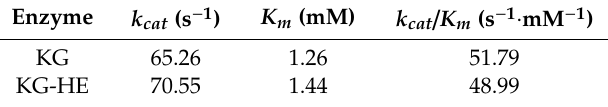
Table 2. Catalytic activities of KG and KG-HE.